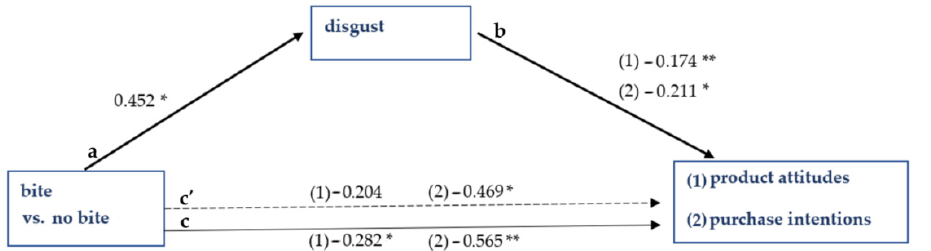
Figure 2. Results of Study 1. The effect of picture type on product attitudes and purchase intentions is mediated by disgust. Note: ** significant at p < 0.01; * significant at p < 0.05; a = effect of independent variable on mediating variable; b = effect of mediating variable on dependent variable; c´ = direct effect of independent variable on dependent variable; c = total effect of independent variable on dependent variable; (1) product attitudes; (2) purchase intentions.